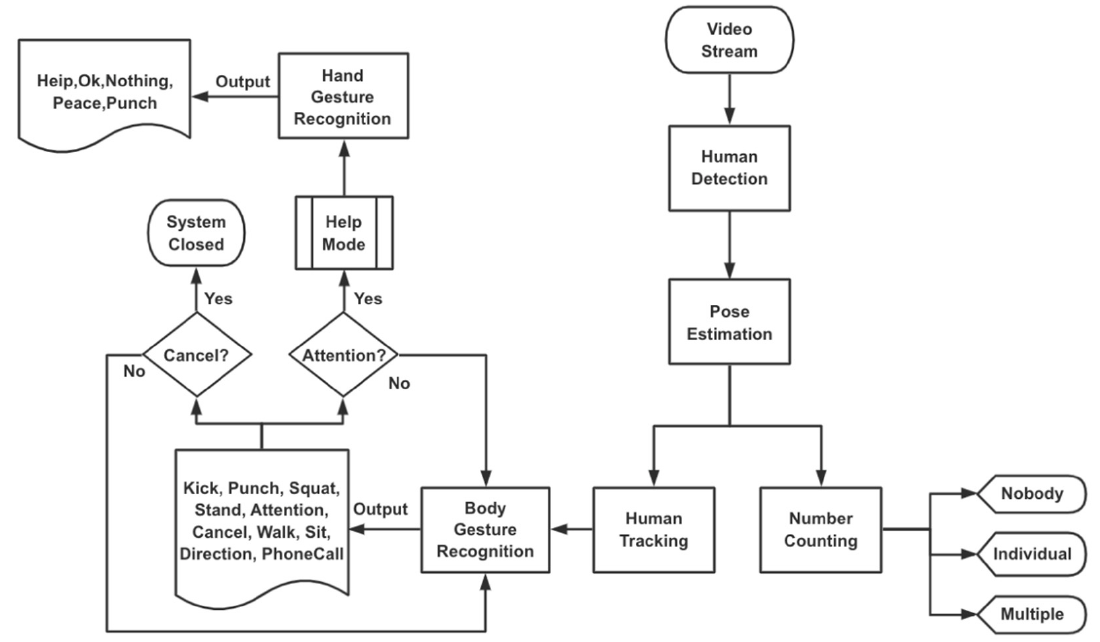
Figure 4. Framework of the whole system.